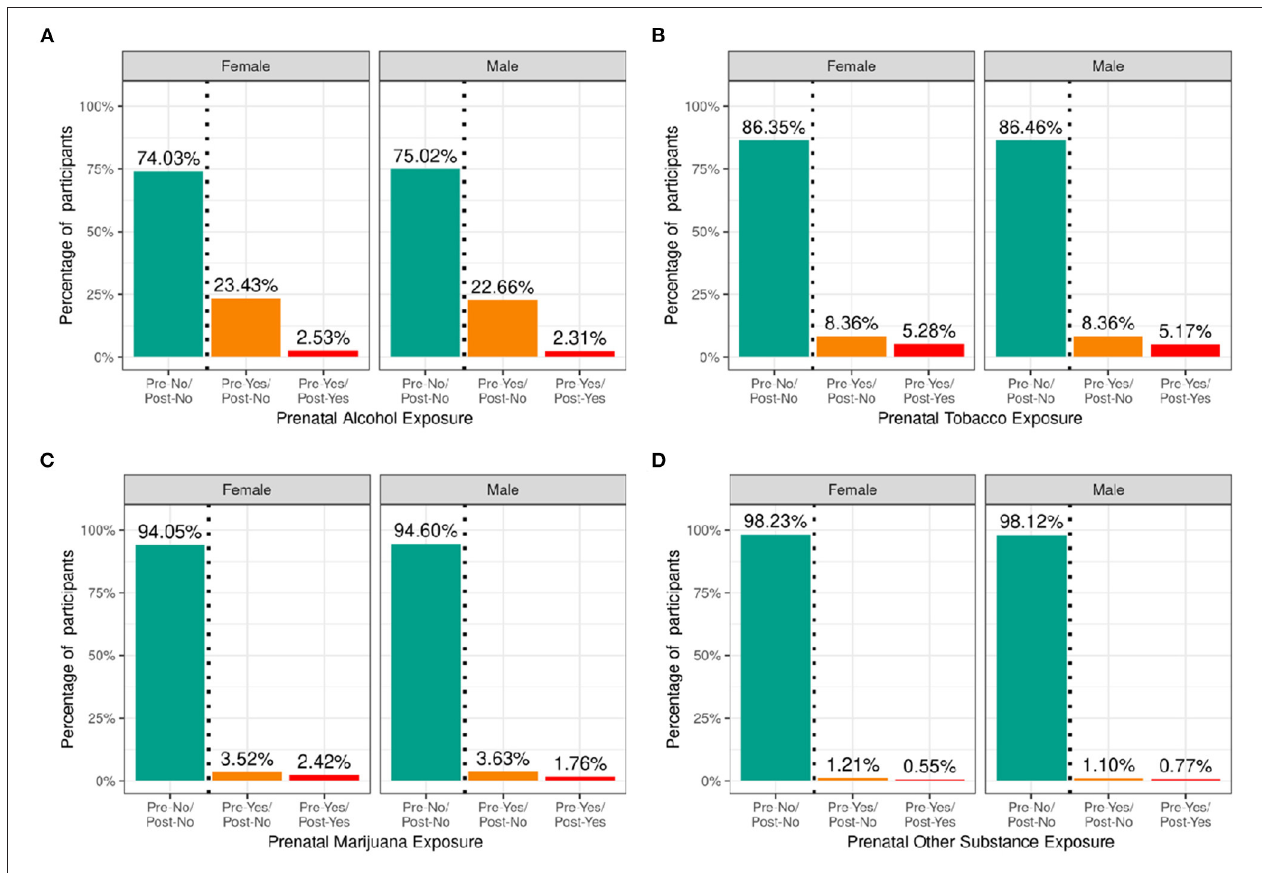
FIGURE 5 | Distribution of participants who experienced prenatal substance exposure. Percentage of participants potentially exposed to alcohol (A) , tobacco (B) , marijuana (C) or other substances (D) prenatally stratified by sex assigned at birth and grouped by reported use pre and post pregnancy recognition: no use pre- or post-pregnancy recognition (green); use pre-, but not post-pregnancy recognition (orange); use pre- and post-pregnancy recognition